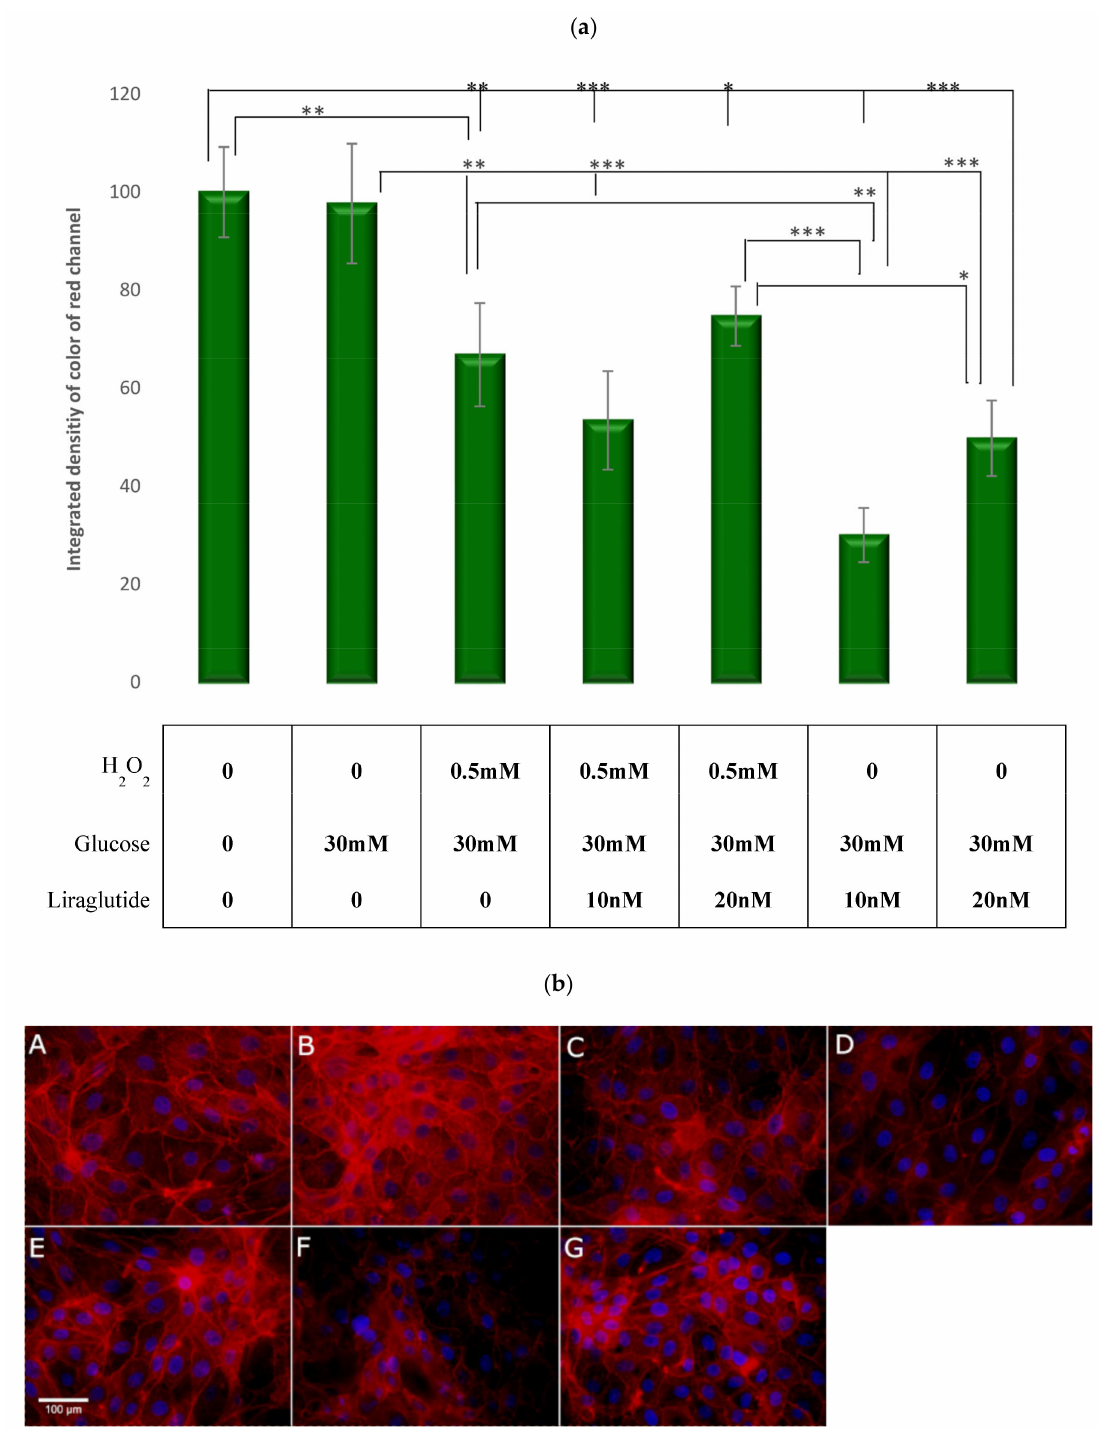
Figure 14. ( a ) Quantification and Visualization of the F-actin cytoskeleton with Rhodamine Phalloidin stain. Levels of total F actin stained by Phalloidin-Rhodamine in the LLC-PK1-treated cell lines (control vs. HG30 and HG30/H 2 O 2 ; HG30 vs. HG30/Lira10 and HG30/Lira20; HG30/H 2 O 2 vs. HG30/H 2 O 2 /Lira10 and HG30/H 2 O 2 /Lira20). Data represent the integrated density of the red color of stained actin per single cell. A higher number equals a more intense stain. One-way ANOVA − 8 with Tukey HSD post hoc test; * p < 0.05, ** p < 0.01, *** p < 0.001. The data F(8,26) = 22.41, p = 7.46 × 10 are shown as the means ± SD (standard deviation) from three independent biological replicates.